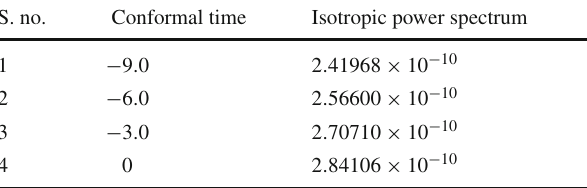
Table 1 Conformal time and corresponding values of the isotropic power spectrum S.